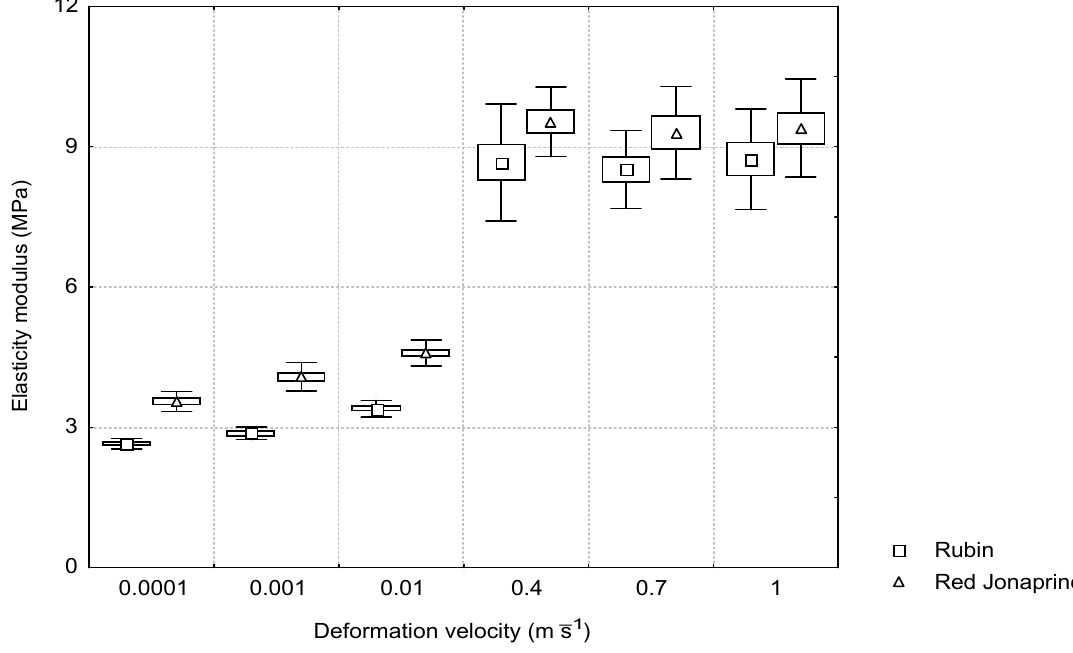
Figure 4. Relationship between the elasticity modulus and the deformation velocity for the two ap- ple cultivars. apple